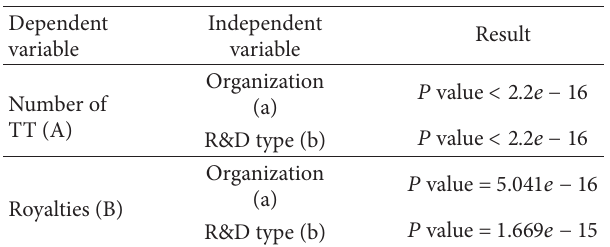
Table 4: Normality